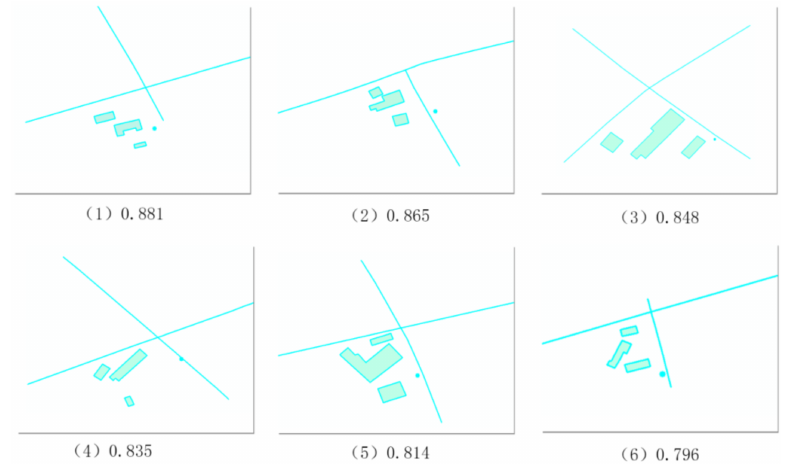
Figure 20. Retrieval